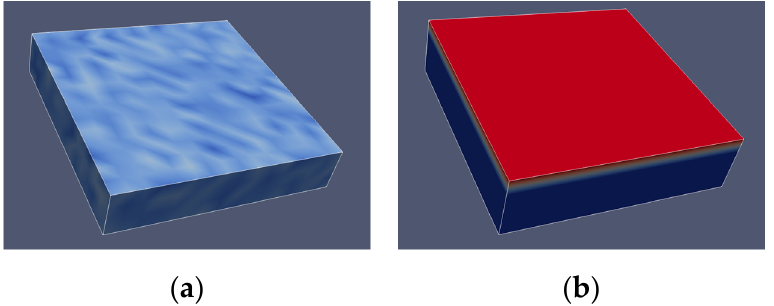
and C FE is a ferroelectric capacitor.